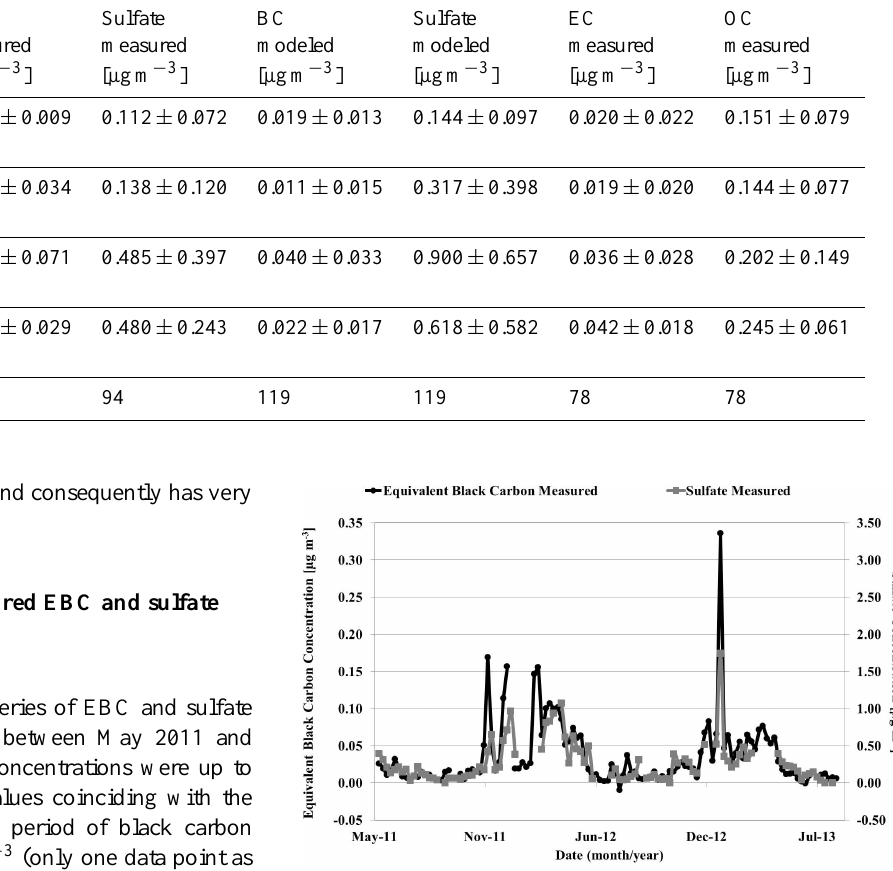
Figure 2. Weekly measured EBC and sulfate concentrations in µgm − 3 from May 2011 to August 2013 at VRS (Station Nord), North Greenland. Here, EBC and sulfate concentrations exhibit very similar patterns with maximum concentrations in winter and spring compared to minimum concentrations in